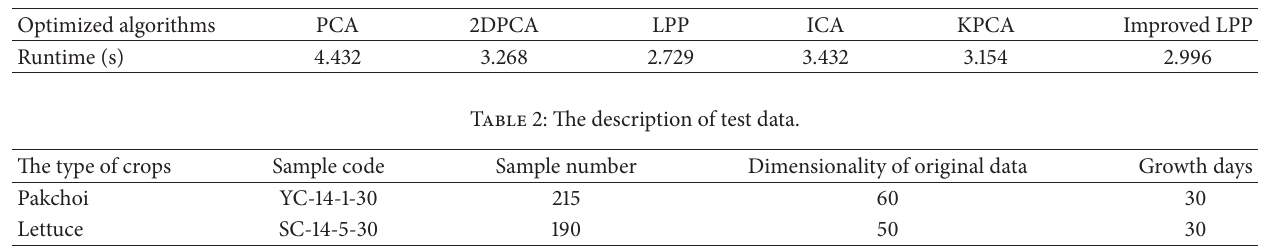
Table 1: Efficiency comparison among different algorithms.